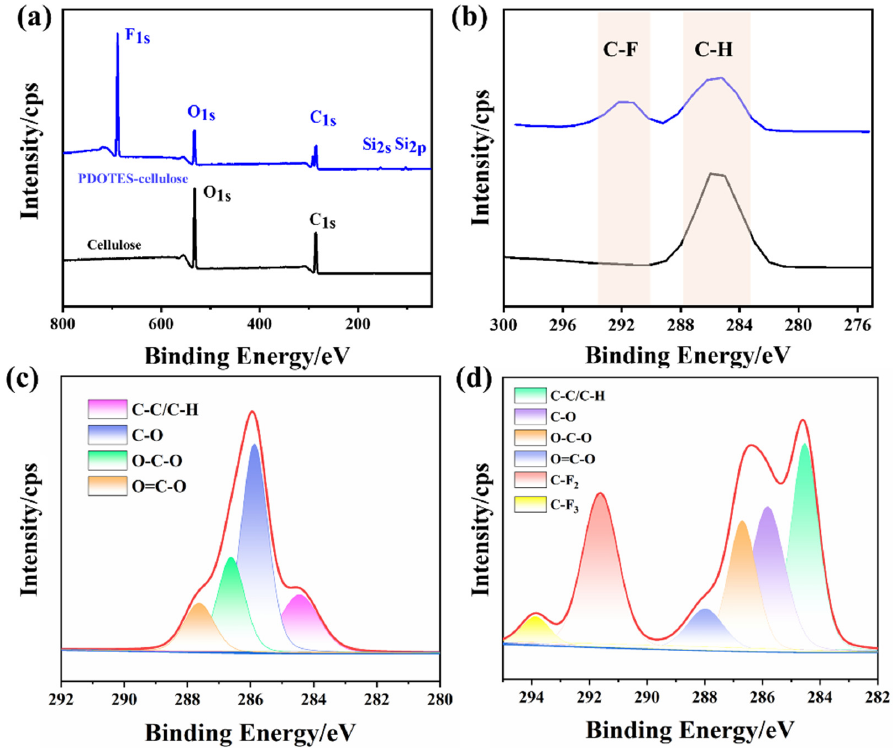
Figure 5. ( a , b ) Full XPS spectrum before and after cellulose modification; ( c ) C1s peaks on the surface of cellulose; ( d ) C1s peak deconvolution on PDOTES-cellulose surface. Table 1. Cellulose surface element ratios.